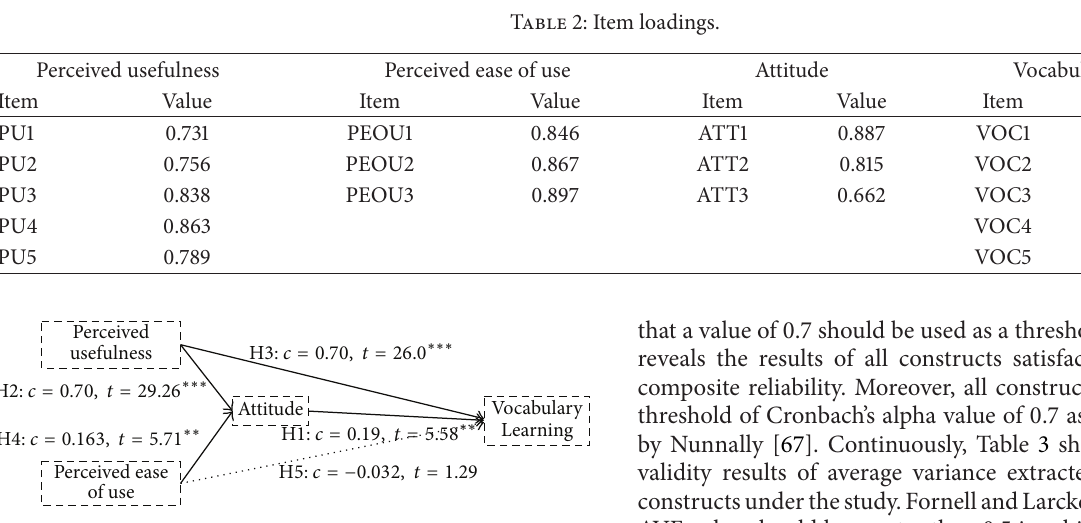
Figure 3: PLS Path Model. Note: c = coefficient, t = t